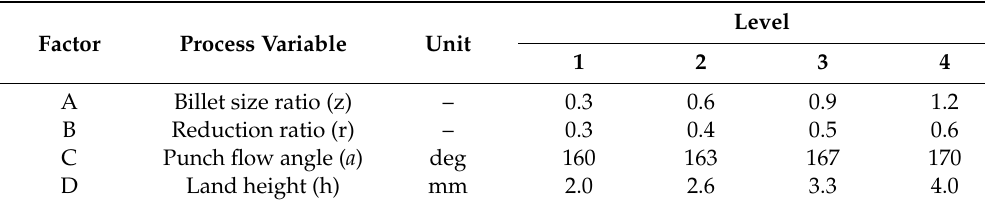
Table 1. Process variables with their